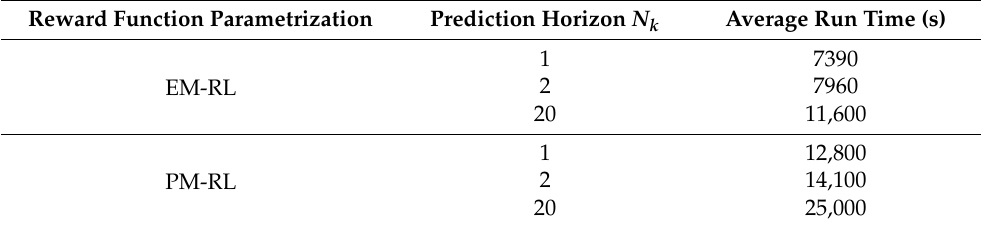
Table A3. Average run times of EM-RL and PM-RL training runs with perfect communication